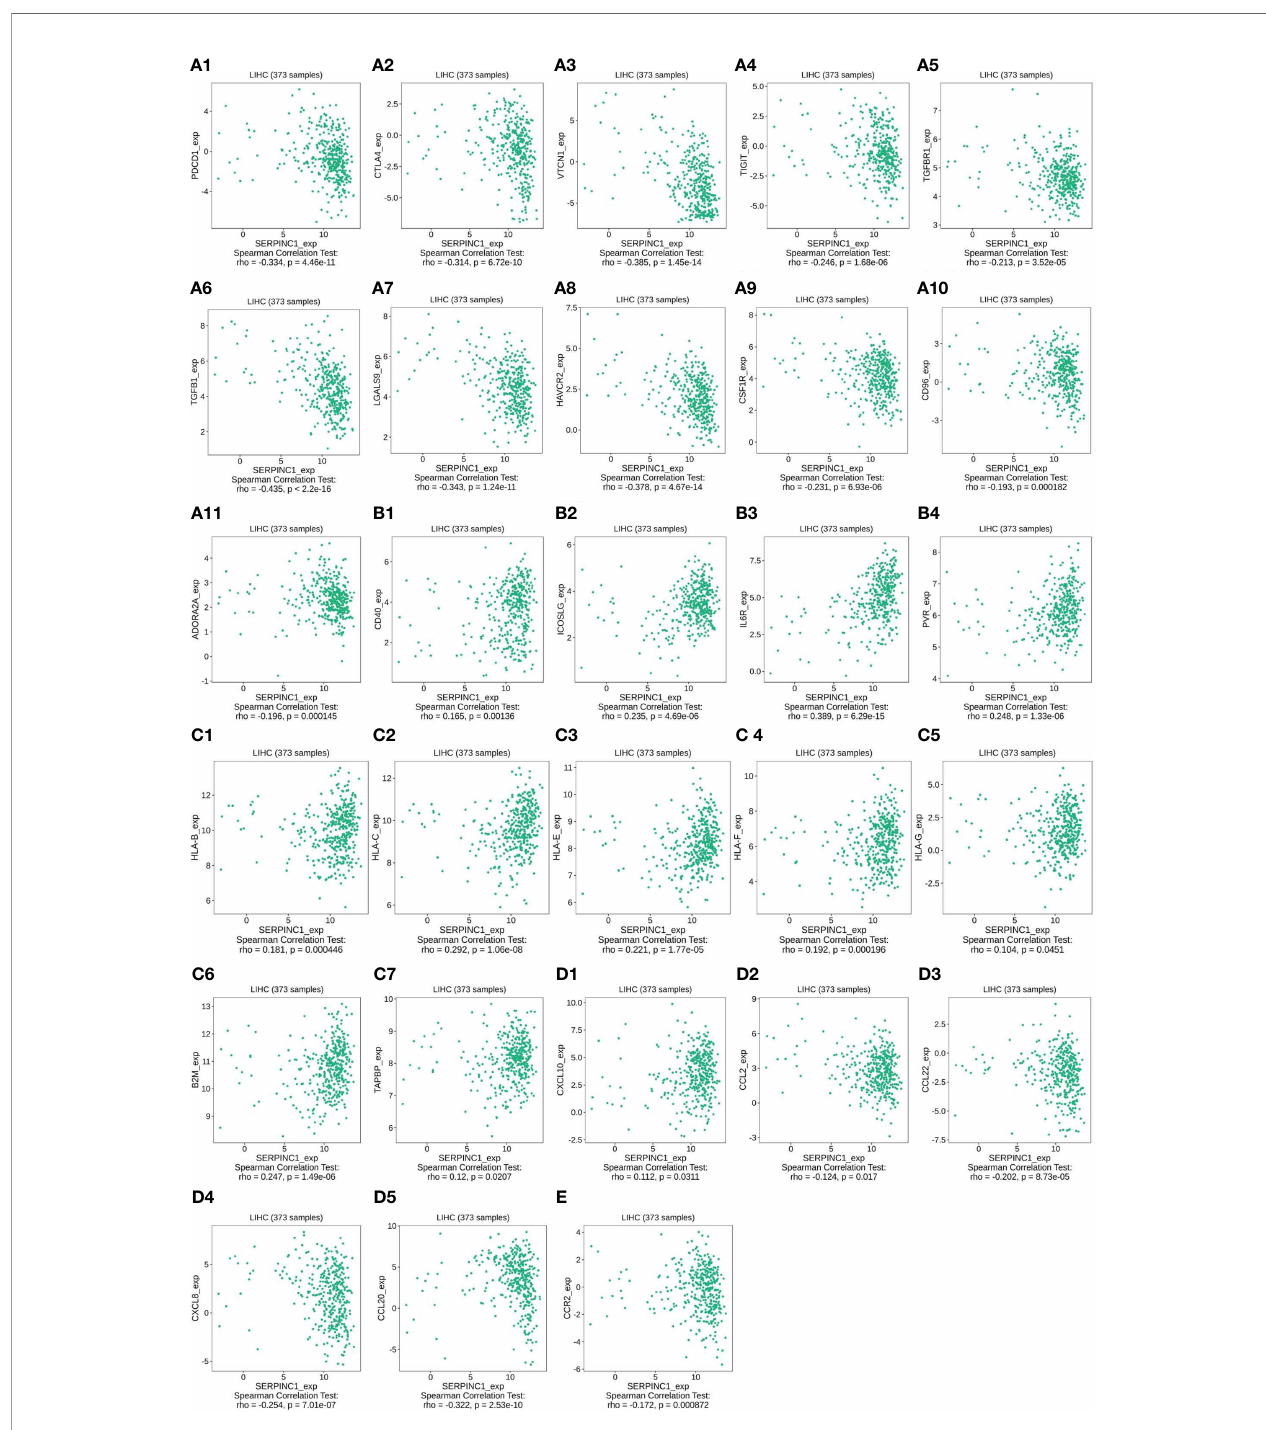
FIGURE 5 | Serpinc1 expression regulated immune molecules in hepatocellular carcinoma. (A1 – A11) , The relationship between immunoinhibitors and serpinc1 expression from TISIDB database. (B1 – B4) The relationship between immunostimulators and serpinc1 expression from TISIDB database. (C1 – C7) The relationship between MHC molecules and serpinc1 expression from TISIDB database. (D1 – D5) The relationship between chemokines on traf fi cking of T cells to tumor or tumor- associated macrophage and serpinc1 expression from TISIDB database. (E) The relationship between receptor on tumor-associated macrophage and serpinc1 expression from TISIDB